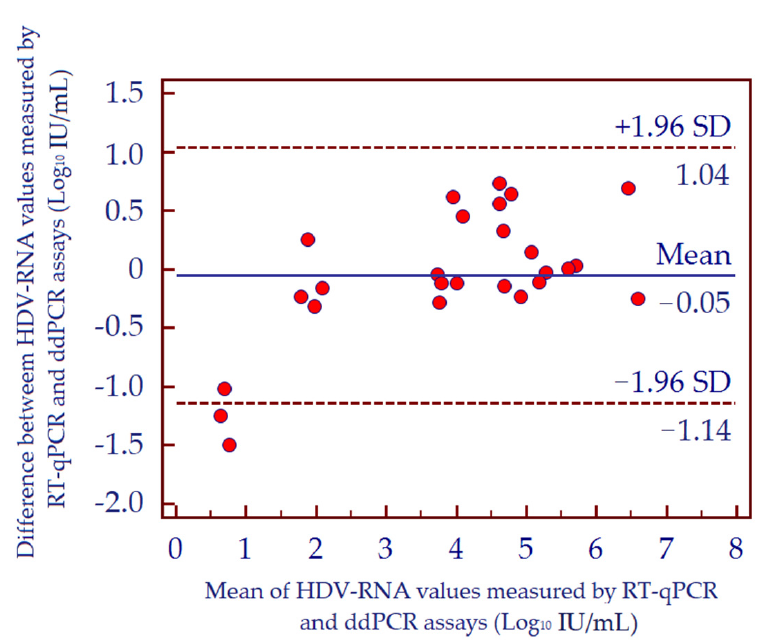
Figure 7. Bland-Altman plot comparing HDV-RNA values quantified by RT-qPCR and ddPCR assays. In the scatter diagram, the means of any two measurements shown in the x axis are plotted against the difference between those two measurements reported in the y axis. The blue horizontal line shows the mean of the differences and red horizontal dashed lines represent the 95% limits of agreement defined as the mean difference +1.96 SD of differences (1.04 and − 1.14). Abbreviations: